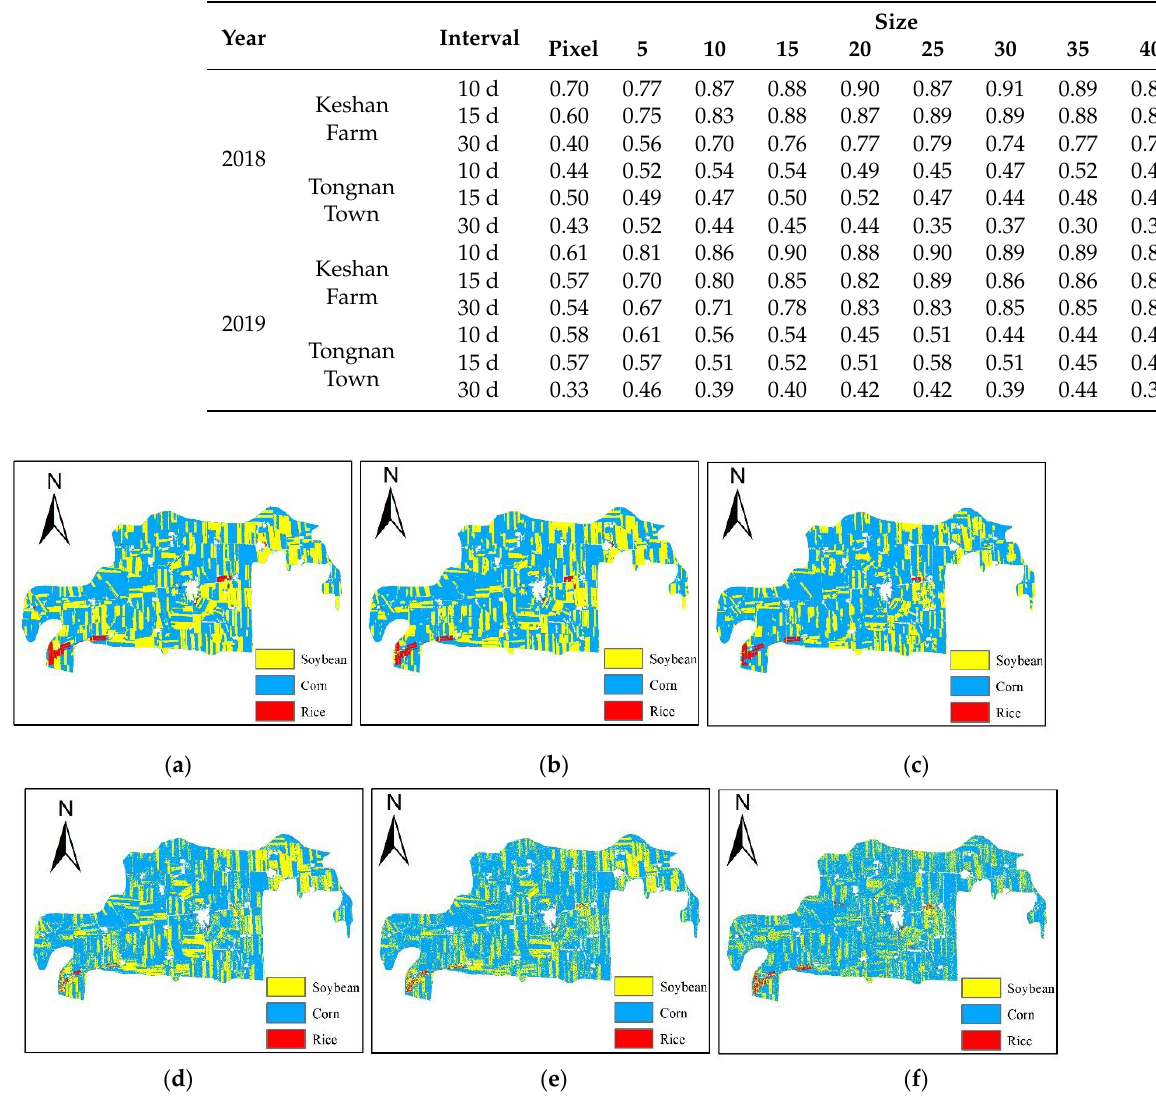
Figure 4. Crop classification results of highest crop classification accuracy with different time intervals in Keshan farm at 2018 (( a ), 10d _size30; ( b ), 15d _size25; ( c ), 30d _size25; ( d ), 10d _Pixel; ( e ), 15d_Pixel; ( f ), 30d_Pixel).